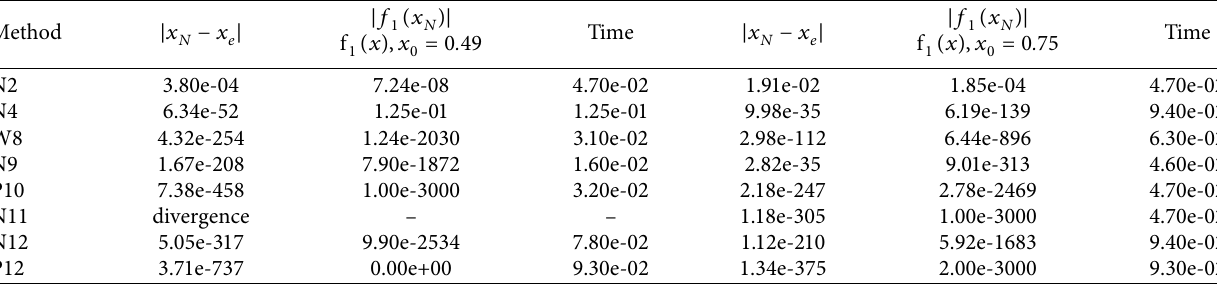
Table 1: Comparison of several methods with the same number of iterations ( N � 4 ) for the Plank’s radiation model given in Problem 5.